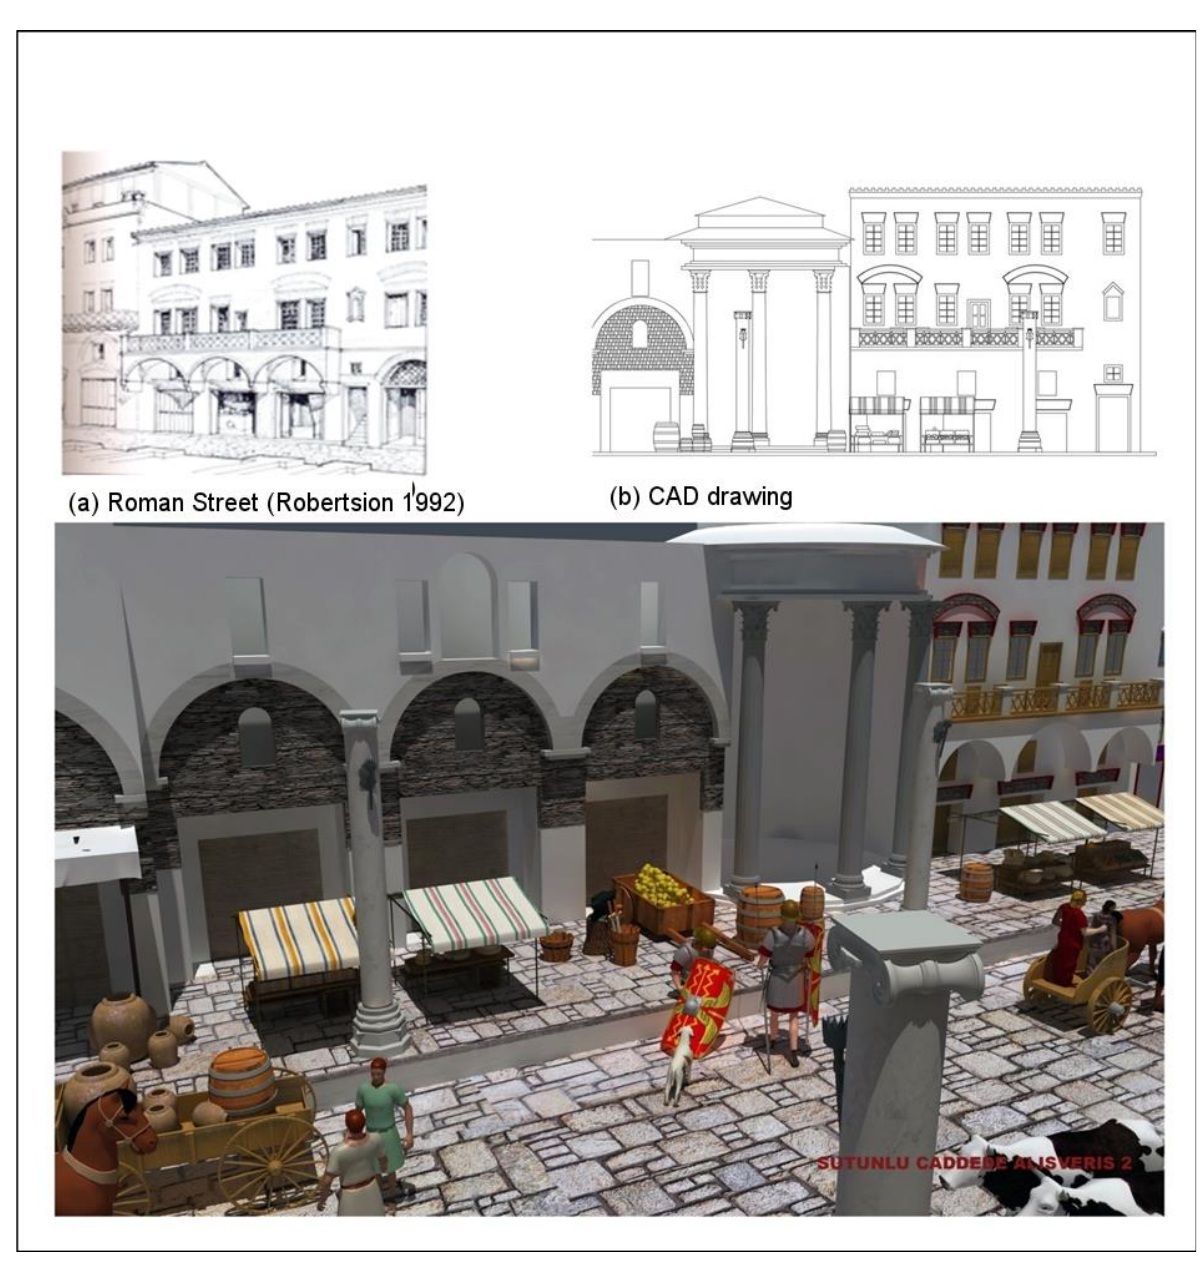
Figure 6. Shop buildings with Roman architecture of the ancient period, modeled for virtual Antioch, with data sources above.